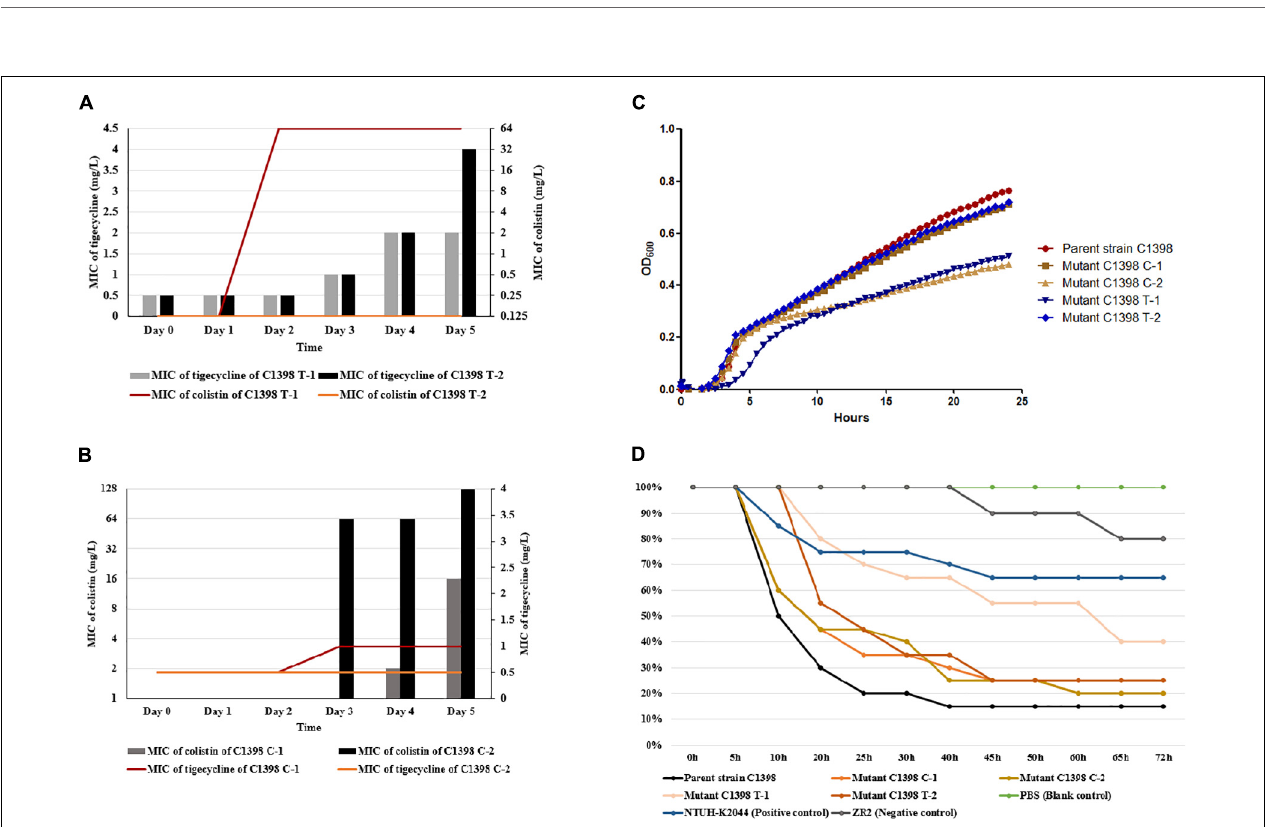
FIGURE 3 | Experimental acquisition of colistin resistance and its biological effects on CR-hvKP. (A) Experimental evolution of colistin resistance under tigecycline pressure. (B) Experimental evolution of colistin resistance under colistin pressure. (C) Growth curve for parental strain C1398 and its mutants. Similar kinetics were observed for the parent strain, C1398, and mutants C1398 C-1 ( p = 0.639) and C1398 T-2 ( p = 0.8551), while significant differences in growth kinetics were observed for C1398 C-2 ( p = 0.0028) and C1398 T-1 ( p = 0.0017) when compared to the parental control. Data are presented as the mean ± standard deviation of three independent experiments. (D) Changes in the in vivo virulence of these resistant strains as evidenced by the Galleria mellonella larvae infection model. G. mellonella mortality was evaluated over a 72 h period.